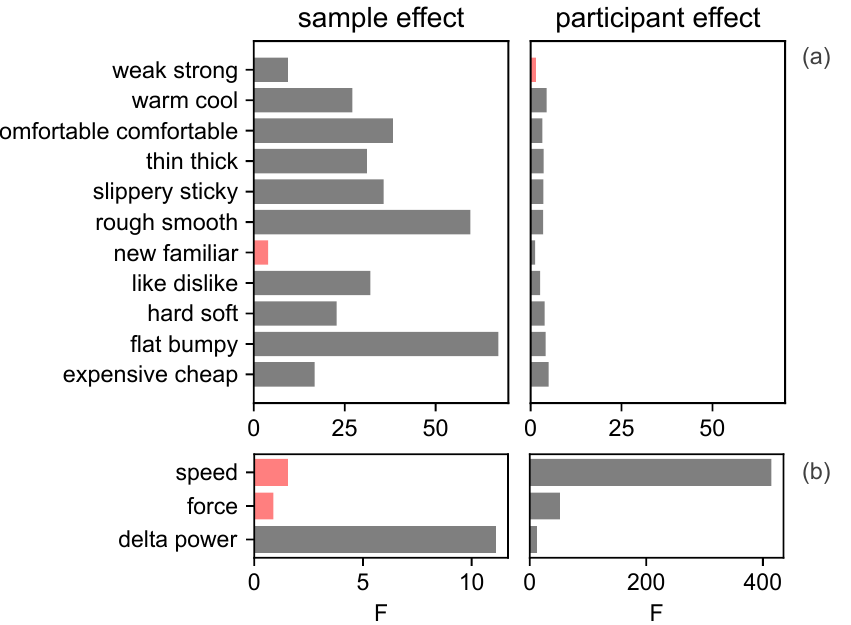
Figure 5. Two-way ANOVA (sensory and interface data). Model with effects for the sample and the participants. ( a ) Sensory attributes and ( b ) fabric–finger interface attributes. The bar length represents the F-value. The attributes in red have a p -value > 0.05 and were regarded as